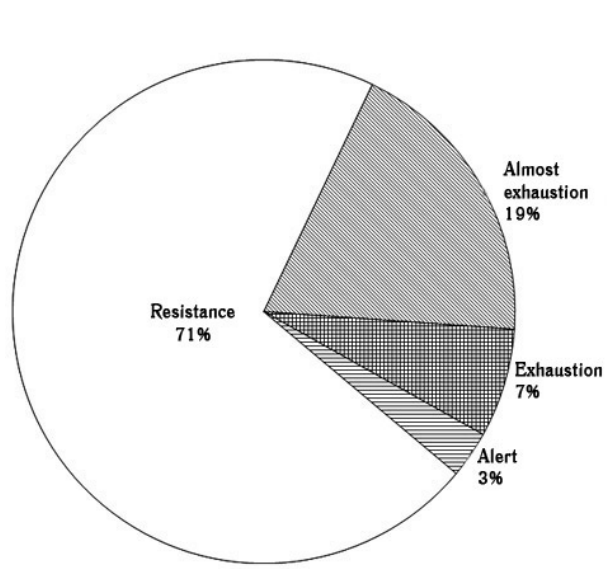
Fig. 4 - Phases of stress in the patients included in the